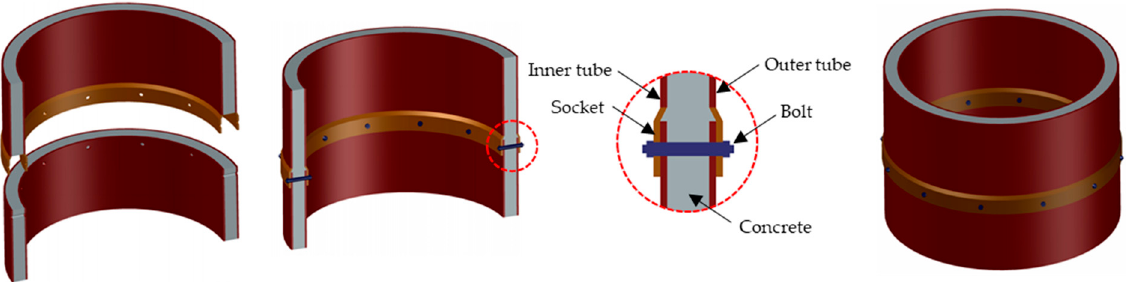
Figure 5. Socket type (Type-S).